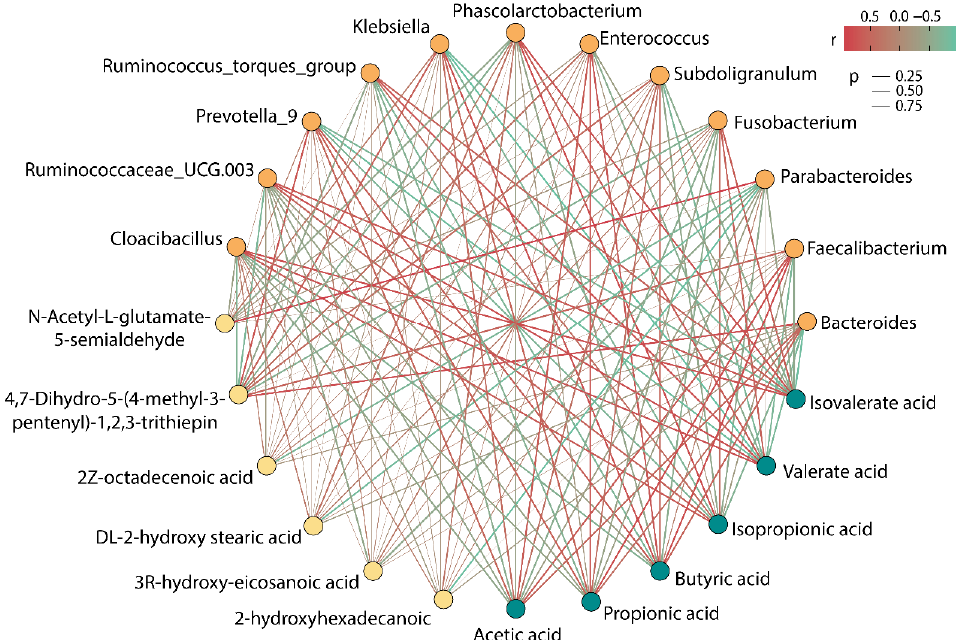
Figure 6. Correlation among gut microbiota, SCFAs, and differential metabolites (the color of dots signifies different categories, where the orange dot represents the microbiota, the green dot represents SCFAs, and the yellow dot represents metabolites).